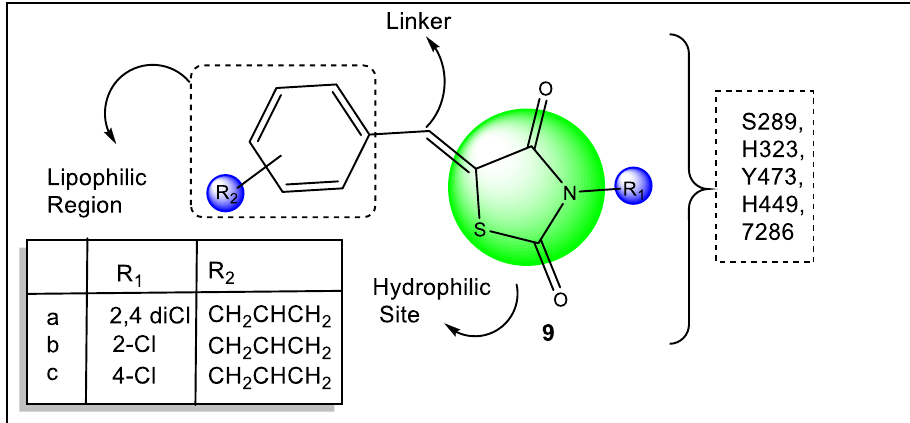
Figure 11. Regions of thiazolidinedione ( 9 ) hybrids are required for binding to